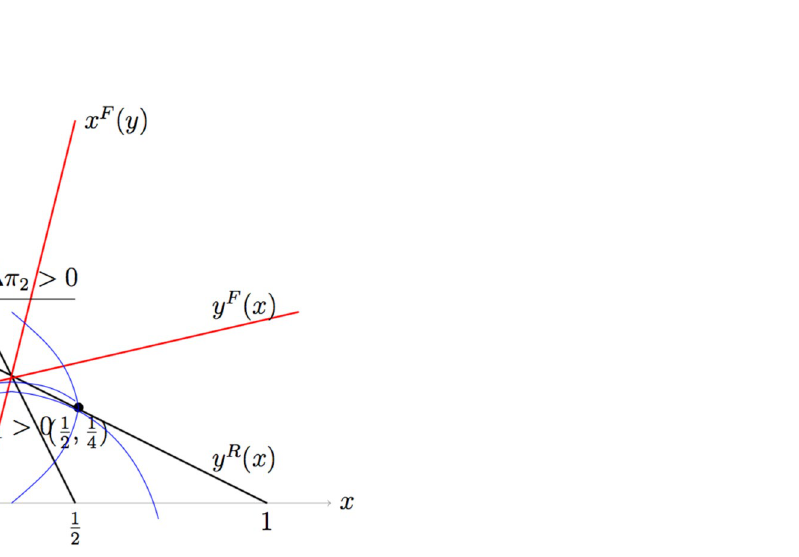
Figure 4. Comparison of bids and payoffs with rational opponent and fair opponent. Black lines denoted by x R ( y ) and y R ( x ) are reaction curves when both players are rational, and the red line denoted by y F ( x ) is the reaction curve when the player is fair. Blue curves are the two players’ indifference curves that yield same utility to each player. The cap-shaped curve is player 1’s indifference curve. His utility increases as it moves downward towards x -axis, while player 2’s utility increases as it moves inward towards y -axis. If the second player is rational, his reaction curve is y R ( x ) , so player 1 chooses the point that gives the maximum utility on y R ( x ) . It is the tangent point of y R ( x ) and the indifference curve, (1/2, 1/4) if α = 0 . If the second player is fair, the tangent point of y F ( x ) and the indifference curve is (3/10, 13/40) if α = 1 .